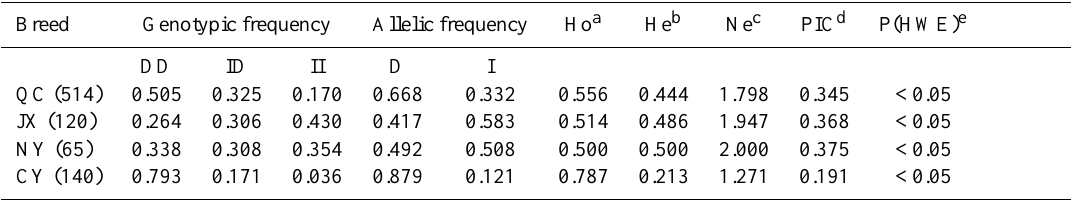
Table 2. Genetic diversity of the 17 bp indel locus within the SMAD3 gene in the four cattle breeds. Numbers in brackets indicate the number of individuals.